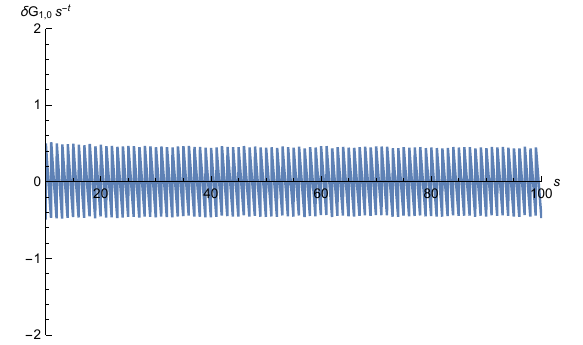
Figure 14 . Error estimate in the Veneziano amplitude spectral density. We plot the di(cid:11)erence (cid:16) R s (cid:17) 1 ds 0 (cid:26) ( s 0 ; t ) (cid:0) ( s + t= 2) t +1 for t = 1 : 2. The result is consistent with (7.9). s t (cid:0)( t +2) 0